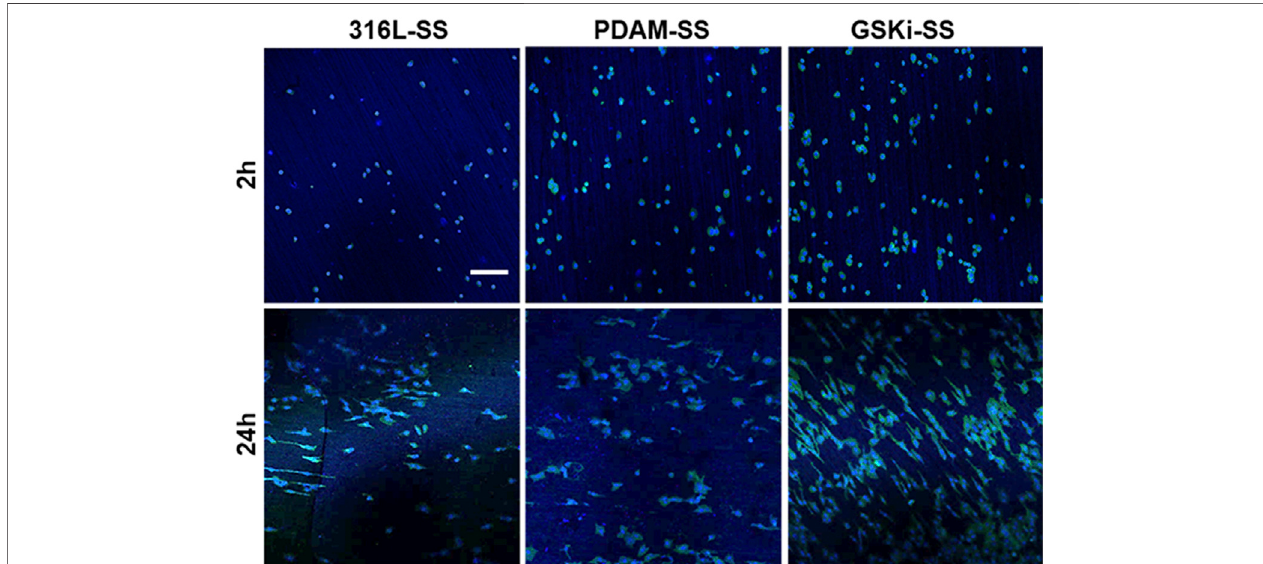
Frontiers in Bioengineering and Biotechnology |